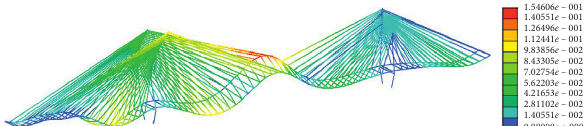
Figure 27: Structural displacement after repair (unit: m).